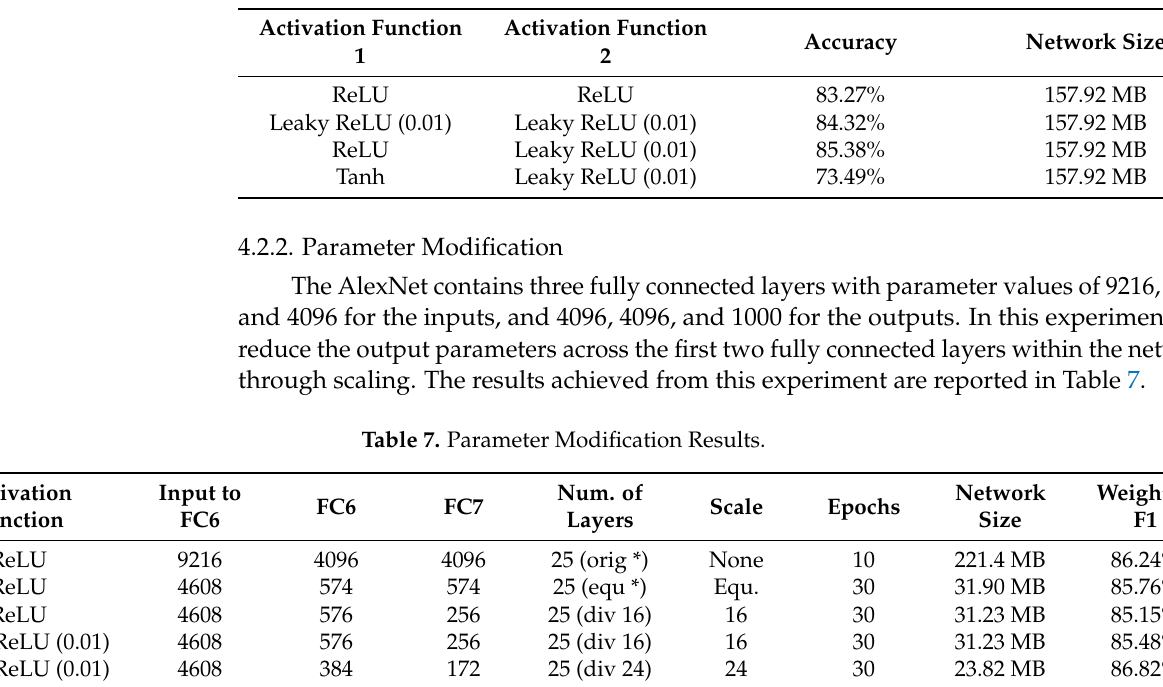
Table 6. Successive Activation Function Combination Summary.